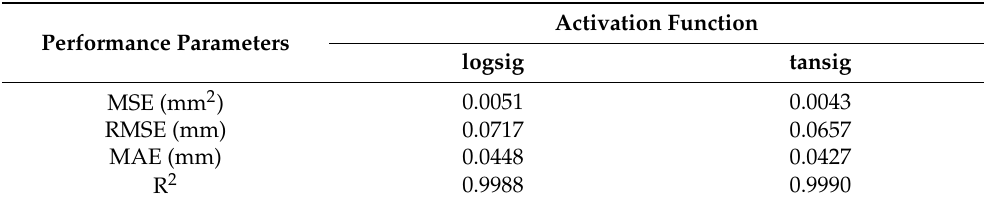
Table 6. The effect of two different activation functions on the predictive performance of the ANN- based model.